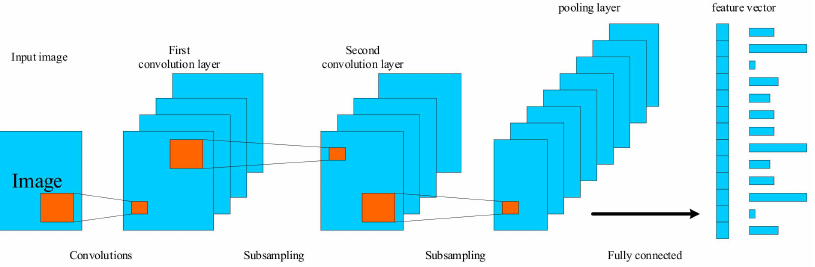
Figure 1. The process of